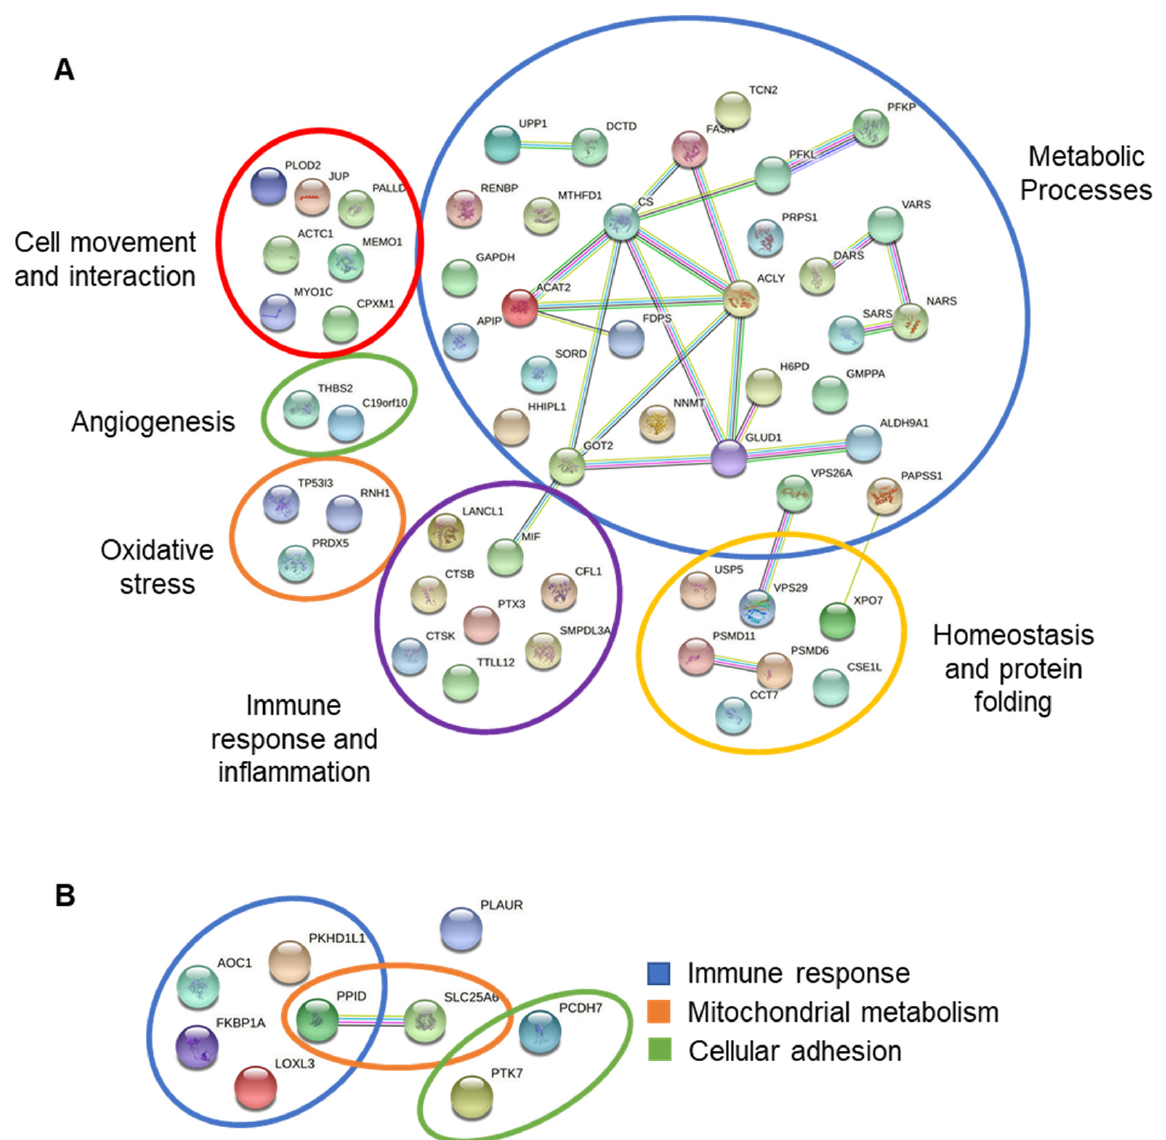
Figure 5. Upregulated ( A ) and downregulated ( B ) protein networks were identified in the fAd-MSC-derived secretome. Schematic representation of both known and predicted interactions between proteins according to the STRING database (v.11.5). Each node represents a protein, and each edge represents an interaction. Only those interactions with mean confidence scores (0.4) are represented. The interactions shown can be either physical or functional associations. The legend for the represented proteins can be found in Table S2.